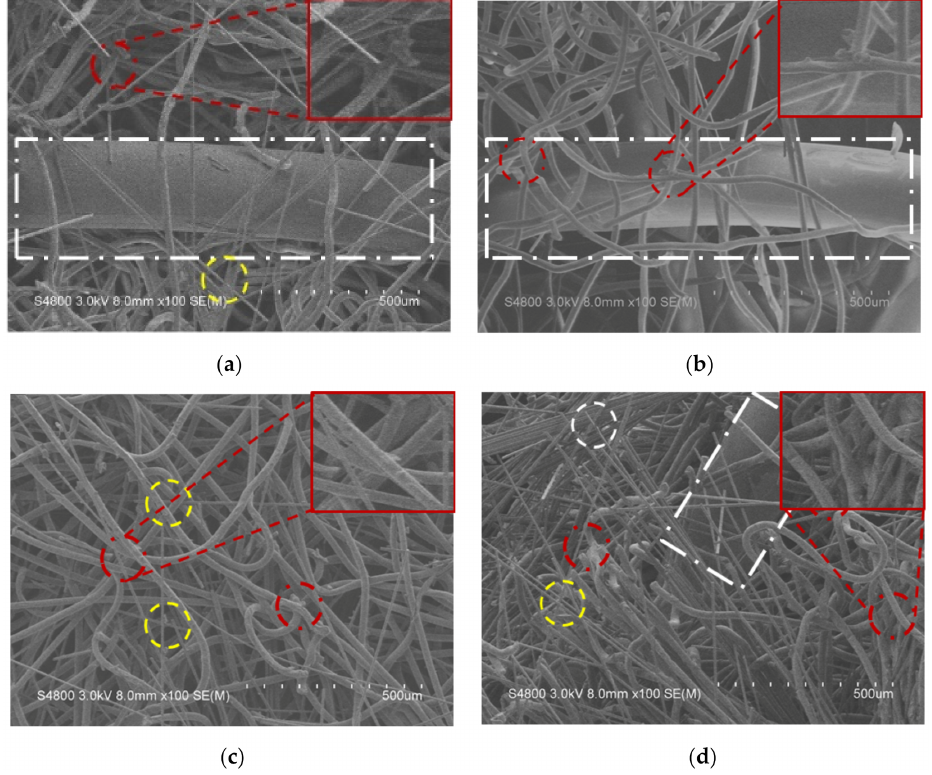
Figure 2. SEM images with a magnification of 8.0 mm × 100 SE (M) of ( a ) NLC, ( b ) NLN, ( c ) CLC, and ( d ) CLN composites observed at an operating voltage of 3.0